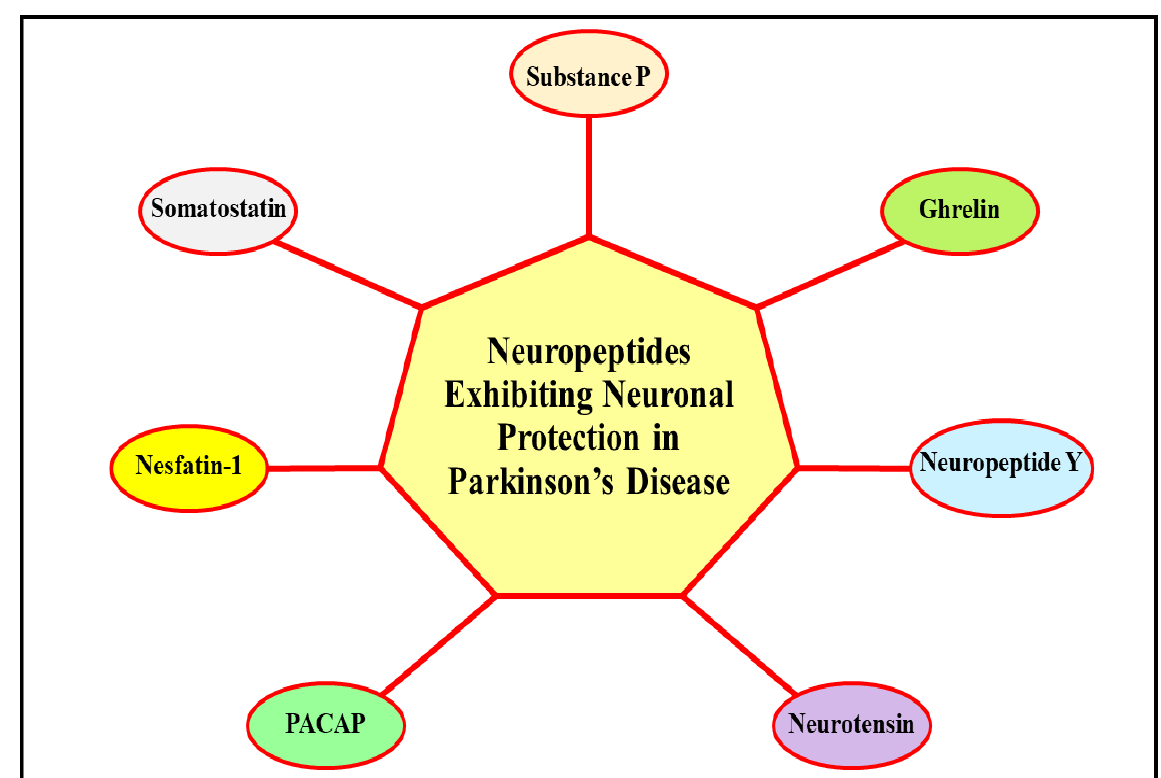
Figure 3. Highlighting the neuropeptides that contribute to significant nerve cell protection in Parkinson’s disease, encompassing substance P, ghrelin, neuropeptide Y, neurotensin, PACAP, nesfatin-1, and somatostatin. PACAP, pituitary adenylate cyclase-activating polypeptide.